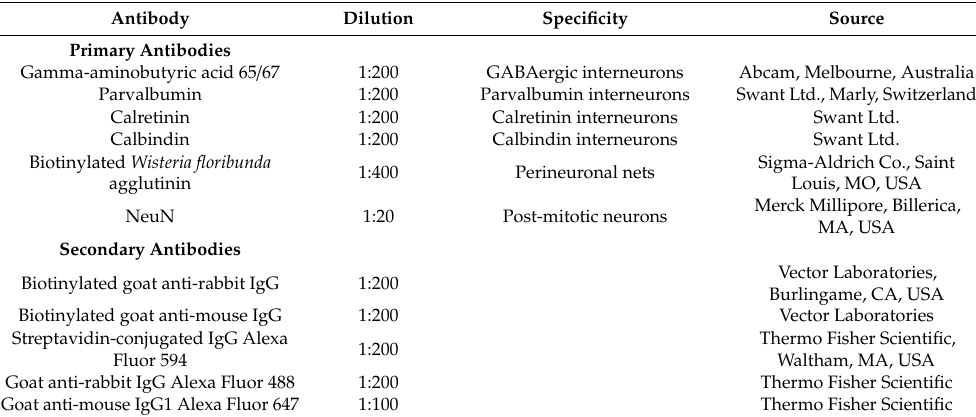
Table 1. Antibodies and markers used for